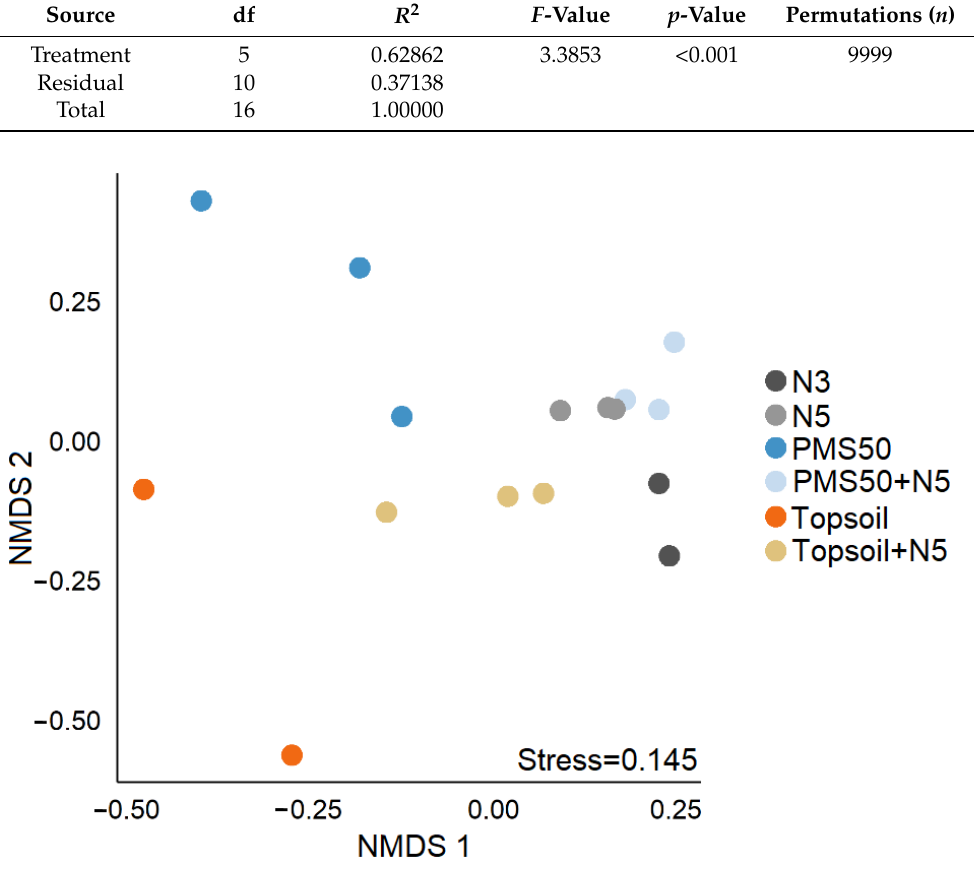
Figure 6. Total percent cover of functional groups (grasses, forbs, and mosses) in relation to recla ‐ mation treatments at the Niobec (treatments: topsoil+PMS35, topsoil, reference sites) (n = 4) and Mont ‐ Wright (treatments: PMS50, PMS50+N5, topsoil, topsoil+N5, N3, N5, and reference sites) (n = 3) sites.